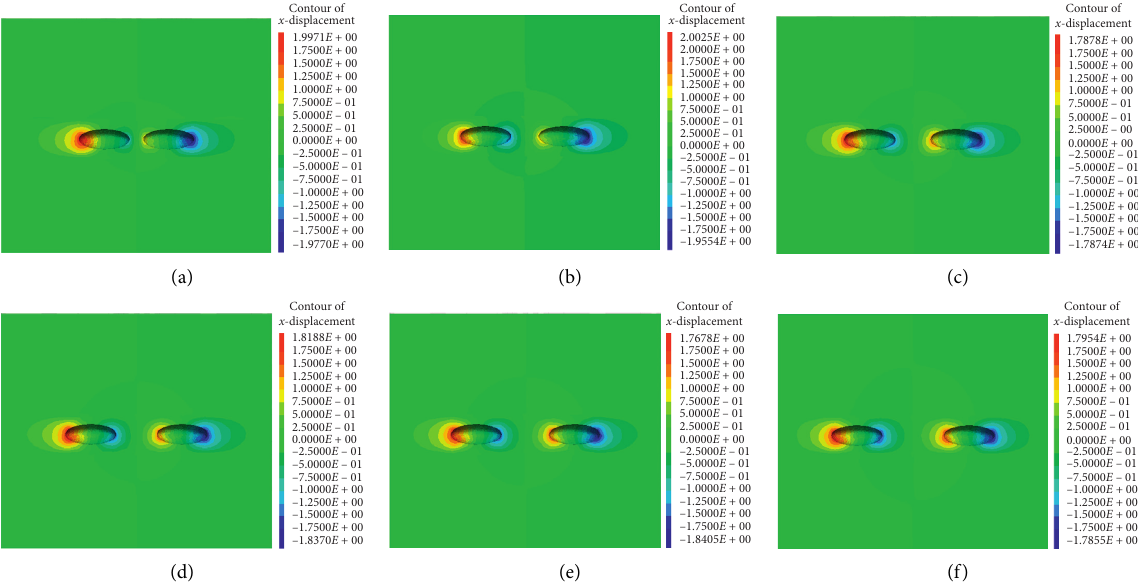
Figure 13: Horizontal displacement distribution cloud map of the double-cavern horizontal salt rock underground storage with different pillar widths (20 a ). (a) d � 40m; (b) d � 80 m; (c) d � 100m; (d) d � 120m; (e) d � 140m; and (f) d � 180m.